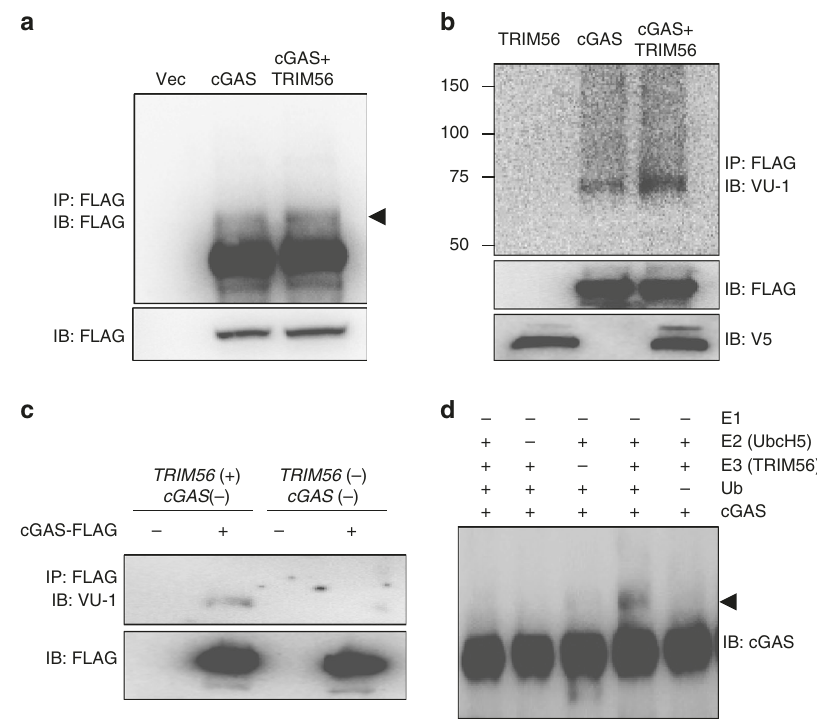
Fig. 3 TRIM56 mono-ubiquitinates cGAS. a , b HEK293T cells were transfected with the indicated plasmids. Twenty-four hours after transfection, whole- cell lysates (WCLs) were used for immunoprecipitation and immunoblotting, as indicated. c WCLs from L929 cell lines were used for immunoprecipitation and immunoblotting, as indicated. d Immunoblot analysis of the in vitro ubiquitination with the indicated combinations of ubiquitin, puri fi ed cGAS, E1, UbcH5 E2 enzymes, and TRIM56 (E3). Data in a , b are representative of three independent experiments. Data in c , d are representative of two independent experiments. Full blots are shown in Supplementary Fig.